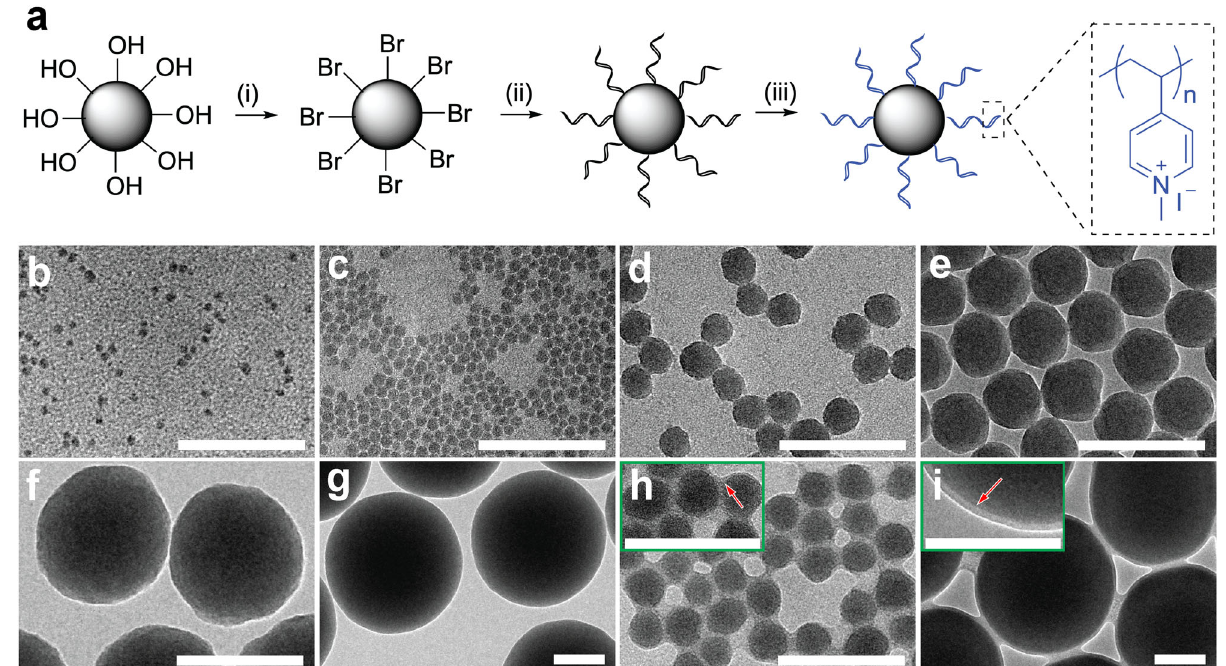
Fig. 1 Synthesis and characterization of model NPPBs. a Schematic of the synthesis design. (i) Silica nanospheres of well-controlled sizes carrying surface derivatives of ATRP initiators were fi rst prepared, followed by (ii) the growth of well-de fi ned P4VP brushes on the silica nanospheres via SI-ATRP, and (iii) the formation of NPPBs by converting the P4VP brushes into hydrophilic and cationic P4MVP via a quaternization reaction. b – i Representative TEM pictures (scale bar: 100 nm) of the silica nanospheres of systematically increasing diameters, i.e., b S7 ( d = 7.2 ± 1.0 nm), c S10 ( d = 9.9 ± 1.1 nm), d S25 ( d = 25.8 ± 2.4 nm), e S50 ( d = 45.6 ± 2.0 nm), f S110 ( d = 112 ± 10 nm), and g S270 ( d = 270 ± 16 nm), respectively, are shown and compared to those grafted with the P4VP brushes, i.e., h S25@P4VP 31 and i S270@P4VP 32 . Note the P4VP brushes appear as a light-gray shell (pointed by red arrow in the insets) on the dark silica nanospheres. Similarly sized silica nanospheres as shown in b – i are consistent across all TEM pictures of individual samples taken in different experiments ( n = 5).